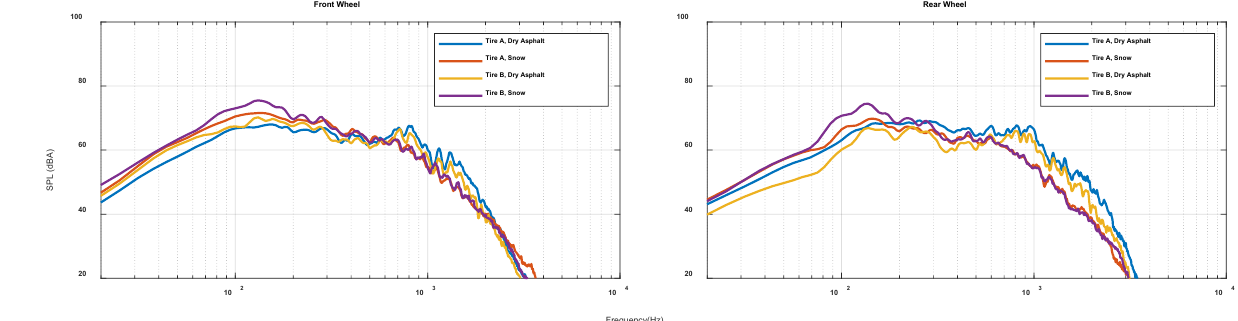
Figure 8. Power spectral density of TPIN signals measured by microphones.